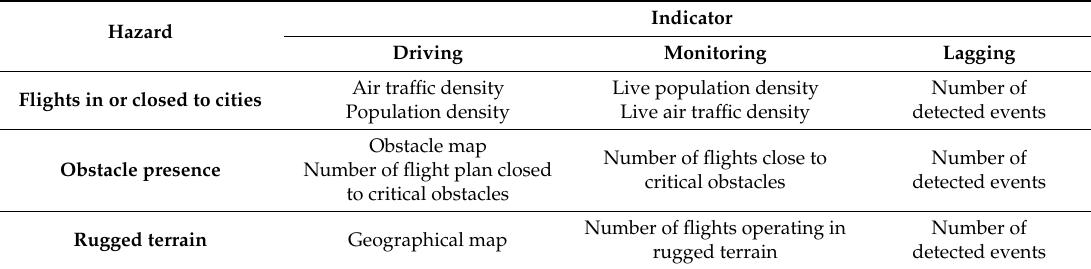
Table 8. Safety indicators regarding population density, land use patterns and building / obstacle height / density